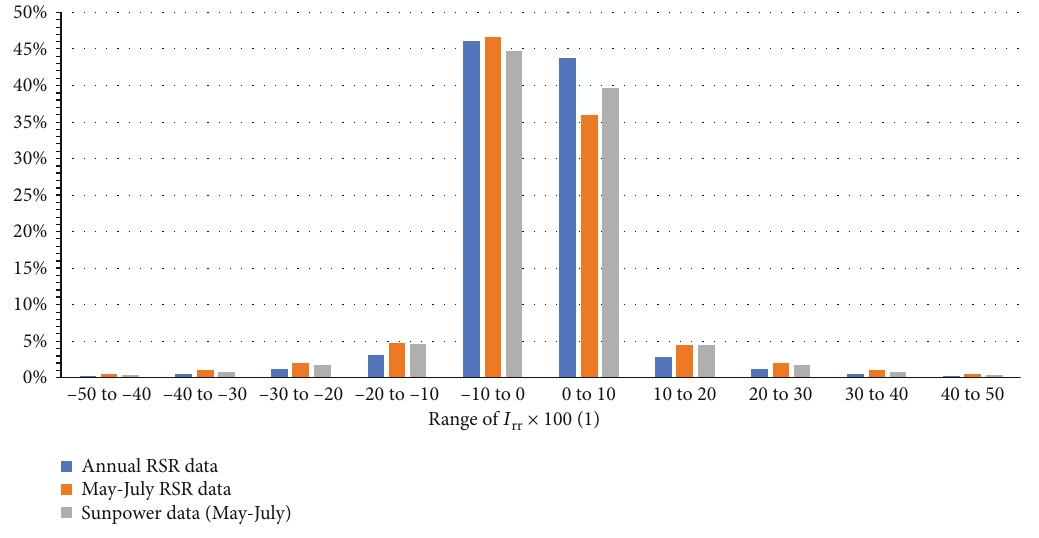
Figure 5: Histogram of the frequency of irradiance ramp rates in various ranges as measured across the entire year at the Oak Ridge RSR as compared to the interval May-July for both the Oak Ridge Tennessee site and the NYPVS SunPower systems. Only ramp rates up to ± 50% are shown as this captures more than 99% of all data in each of the three